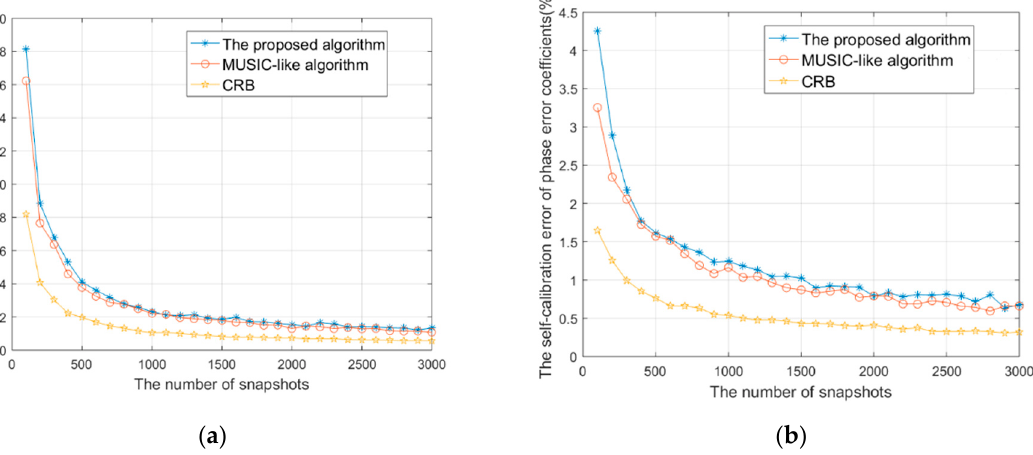
Figure 5. The self-calibration errors versus snapshot number. ( a ) Δ g versus snapshot number; ( b ) Δφ versus snapshot number.